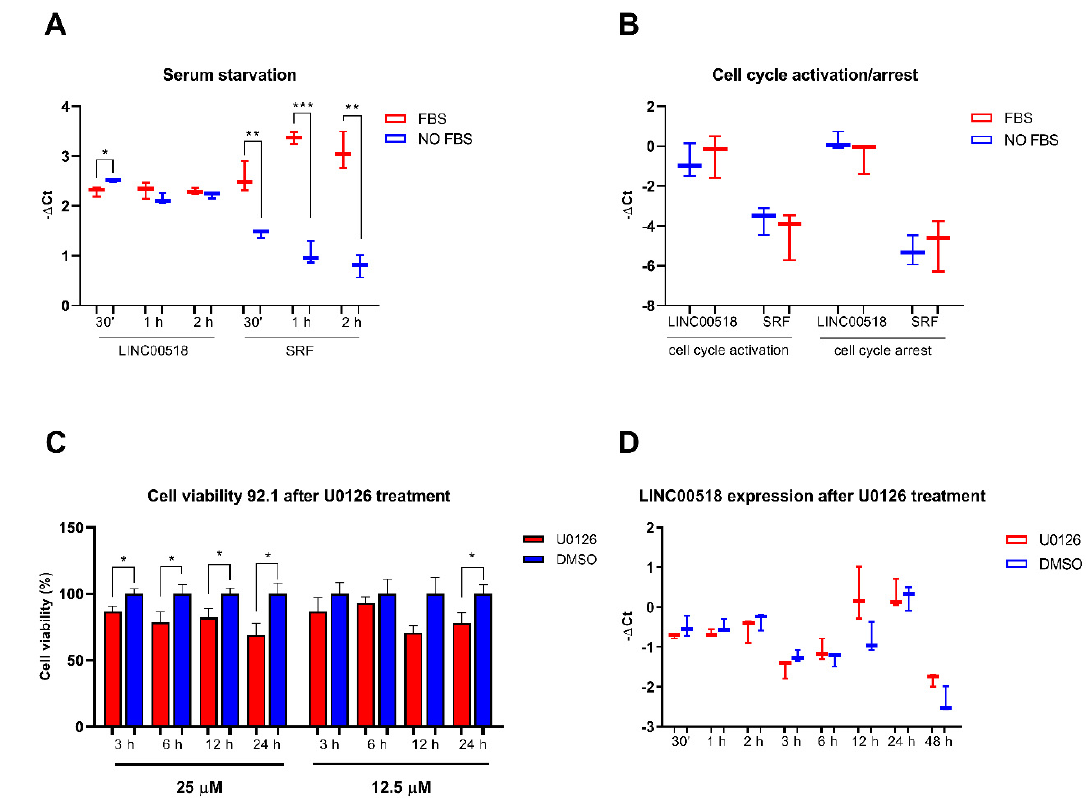
Figure 2. Functional assays aiming to evaluate LINC00518 expression induced by cell cycle in 92.1 cells. ( A ) Expression of LINC00518 during early response to serum-induced cell cycle activation. ( B ) Expression of LINC00518 at24hafterserumsupplement(cellcycleactivation)andserumdeprivation (cell cycle arrest). ( C ) Evaluation of cell viability after U0126 treatment of 92.1 cells through MTT